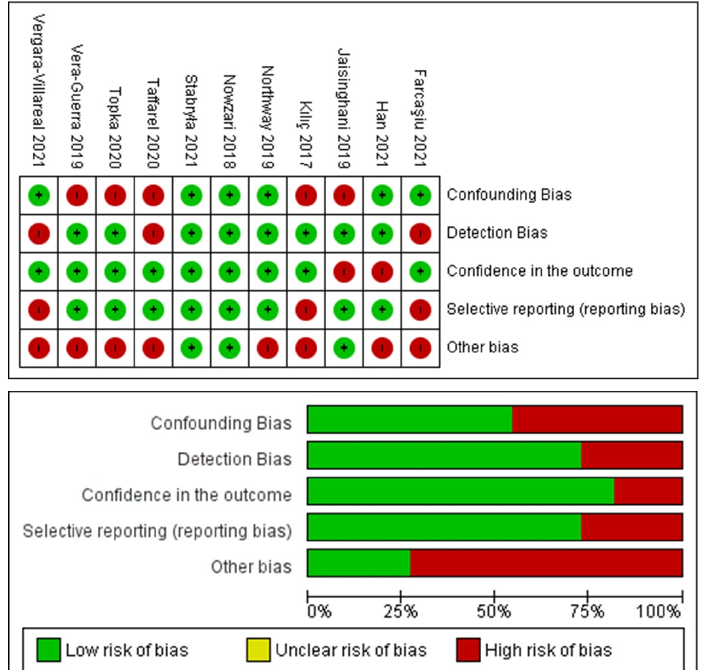
Figure 3. Graphs of the risk ‐ of ‐ bias assessment of the included studies.